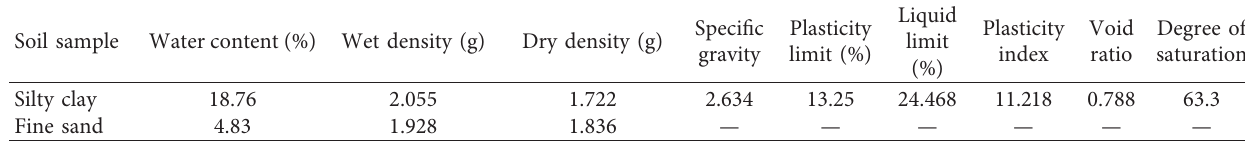
Figure 2: Shield muck sample: (a) fine sand, (b) silty clay. Table 1: Basic physical properties of shield muck.